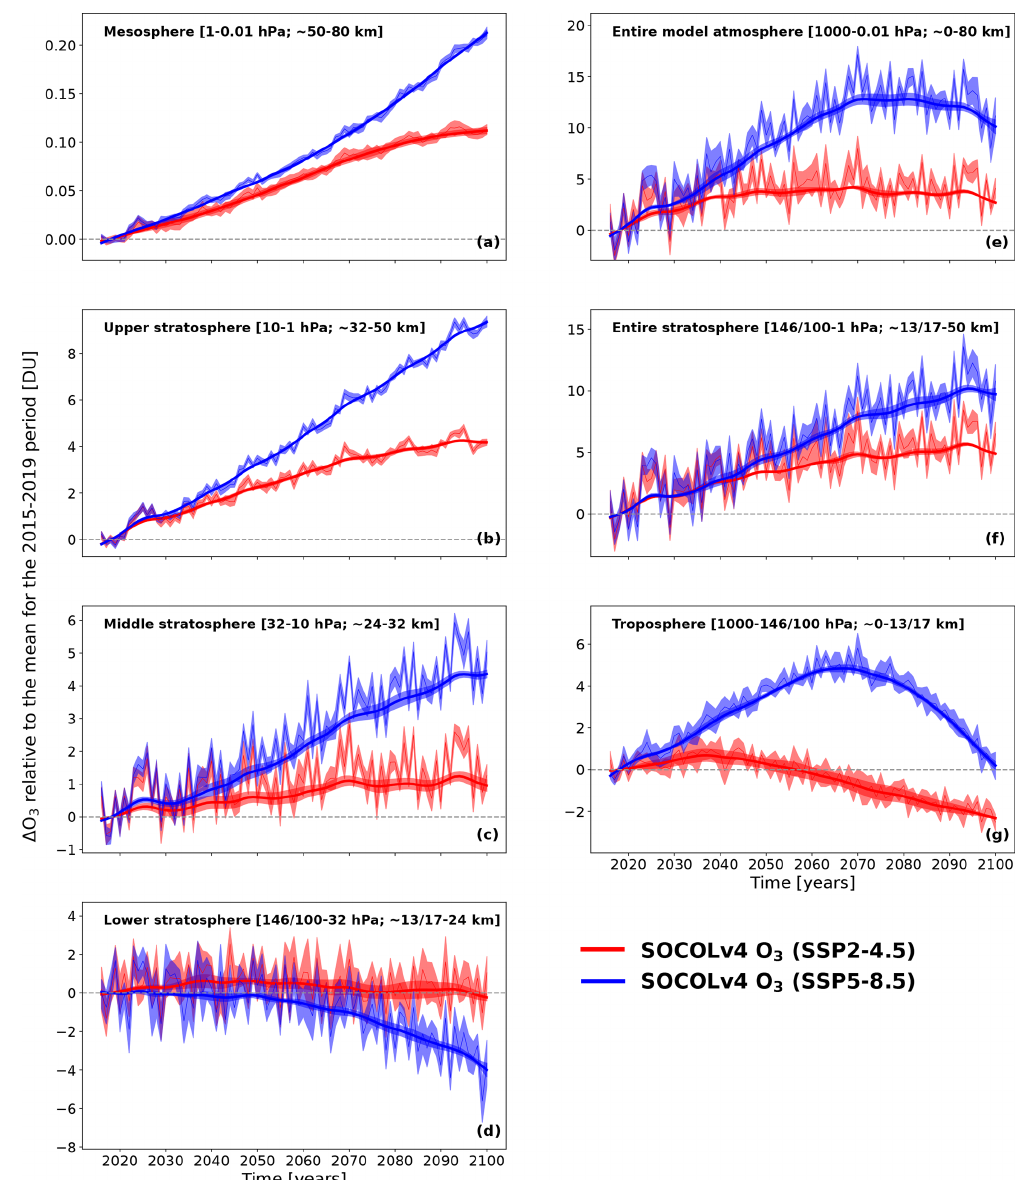
Figure 2. Near-global (60 ◦ N–60 ◦ S) annual mean anomaly ( (cid:49) O 3 ) of column ozone and DLM fits (both in Dobson units – DU) between 2015 and 2099, presented regarding the O 3 mean for the 2015–2019 period. The red line indicates (cid:49) O 3 under the SSP2-4.5 scenario; the blue line indicates (cid:49) O 3 under the SSP5-8.5 scenario. (cid:49) O 3 is presented for (a) the mesosphere, (b) the upper stratosphere, (c) the middle stratosphere, (d) the lower stratosphere, (e) the entire model atmosphere, (f) the entire stratosphere, and (g) the troposphere. Shadings represent the 1 σ standard deviation between ensemble members of the